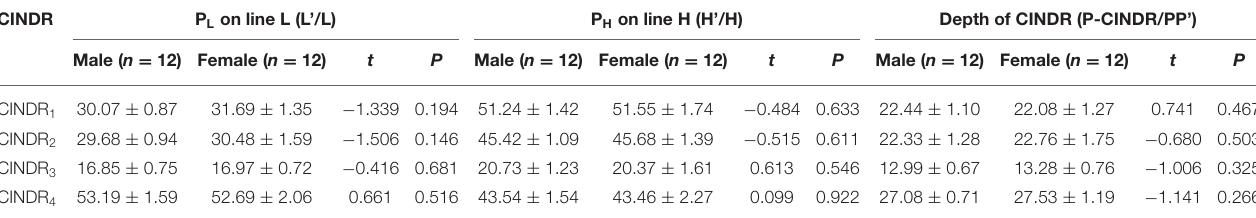
TABLE 2 | Comparison of the location of P L and P H of the CINDRs on lines L and H, respectively, and depth of CINDRs between the male and female in suboccipital muscles (%). CINDR P L on line L (L’/L) P H on line H (H’/H) Depth of CINDR